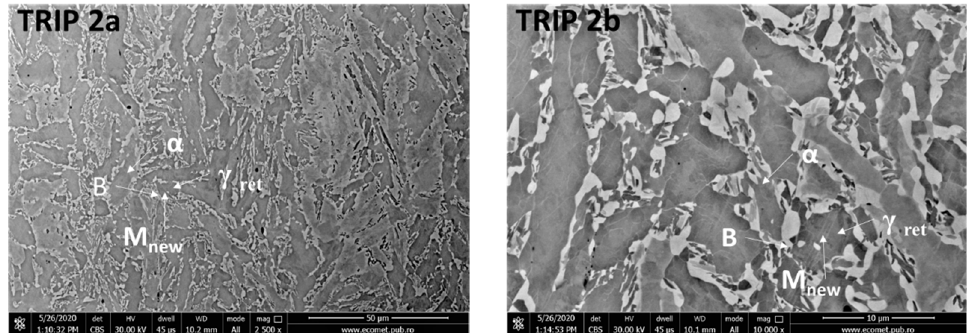
Figure 6. BSE microstructures of TRIP 2 steel (( a , b ) at different magnifications) after impact bending test.